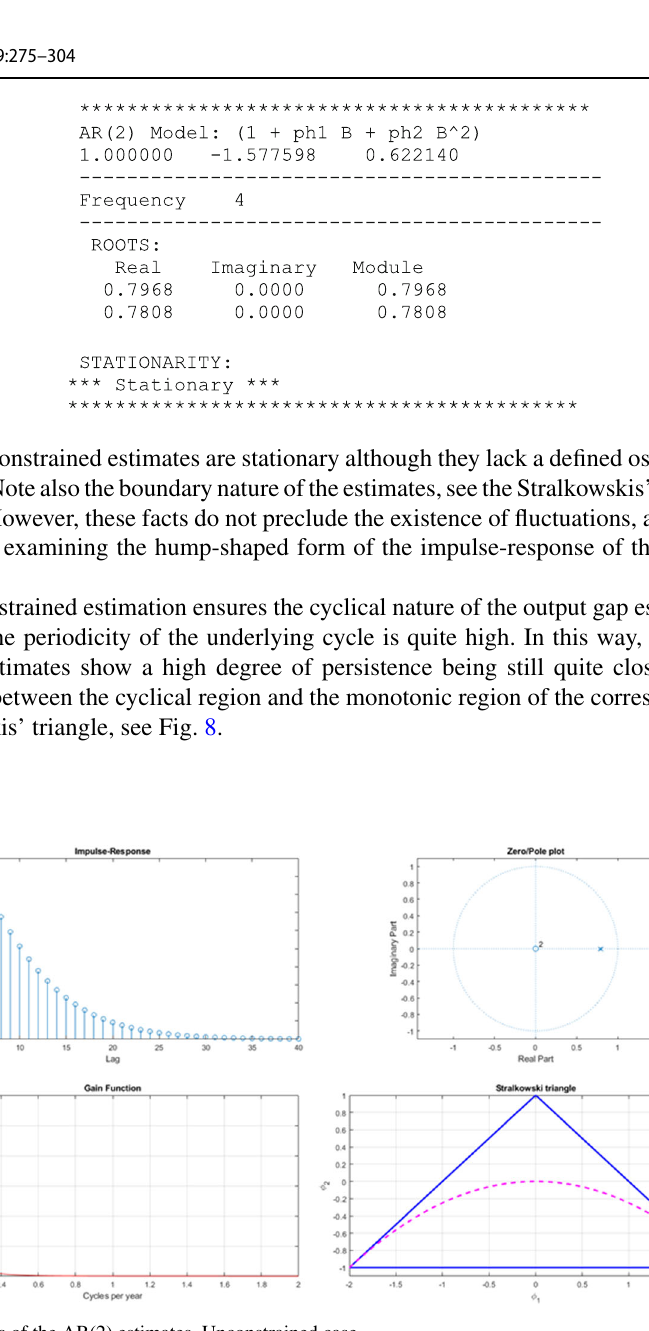
Fig. 7 Features of the AR(2) estimates. Unconstrained